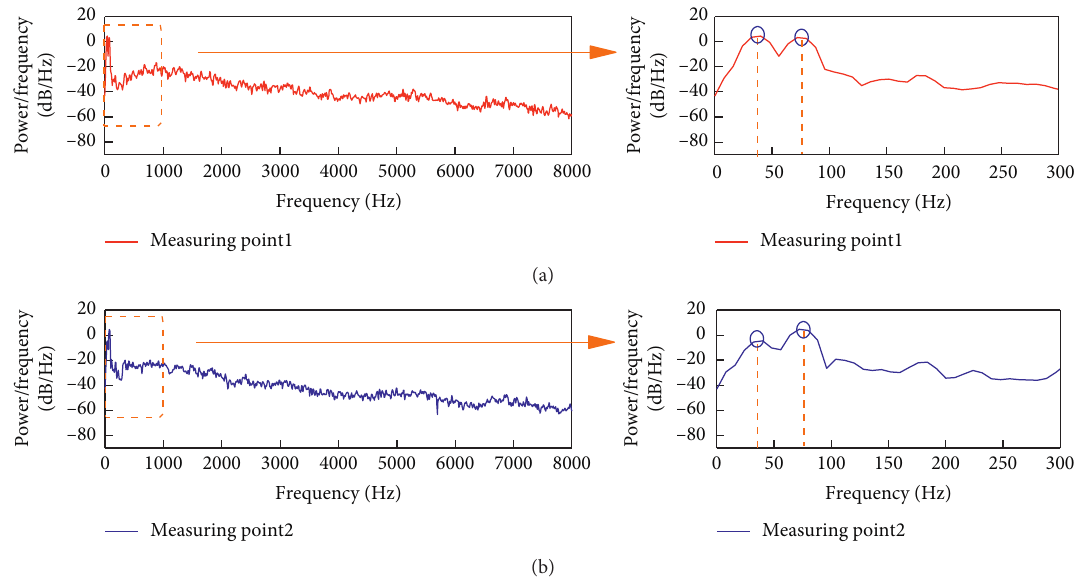
Figure 15: The power spectrum of diesel engine acoustics signals. (a) The power spectrum in measuring point 1. (b) The power spectrum in measuring point